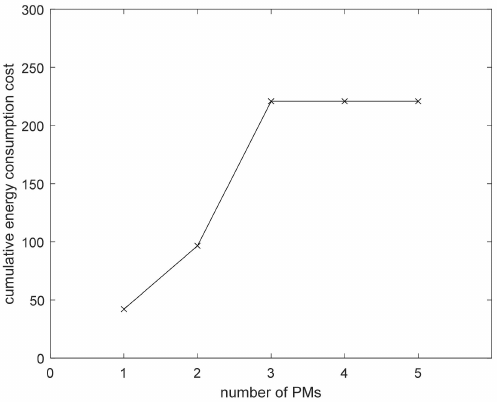
Figure 11. Cumulative value of the energy consumption cost of physical